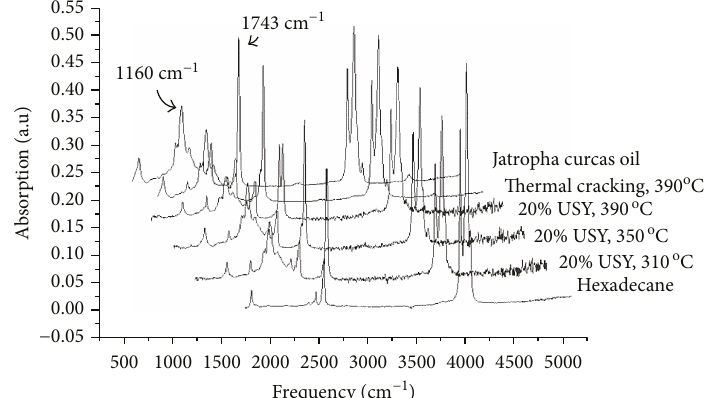
O without metallic 2 3